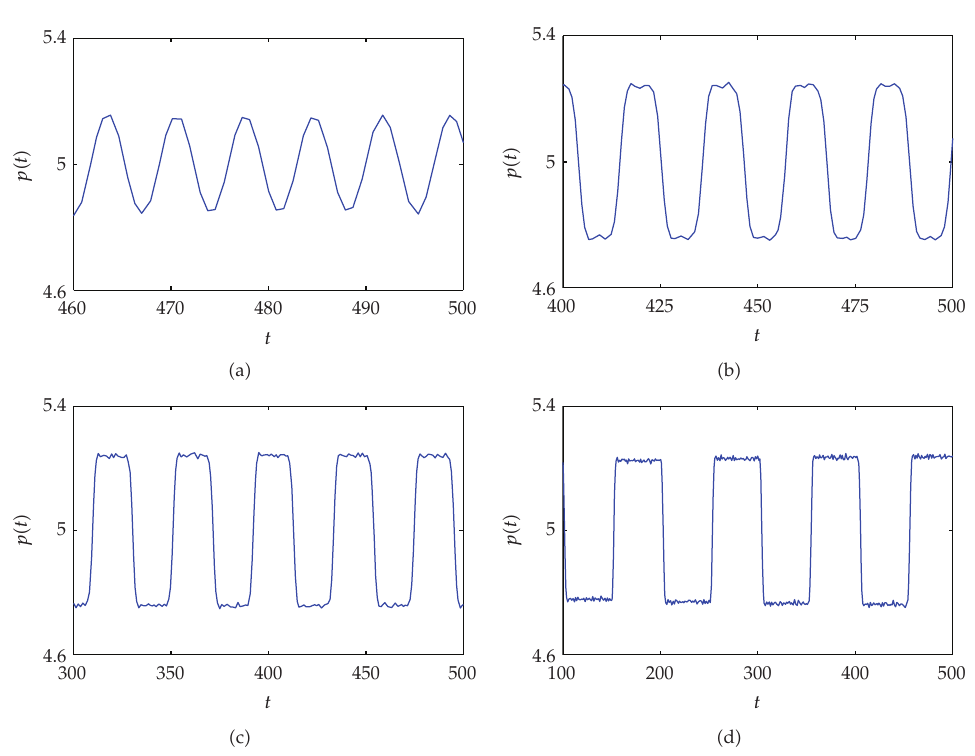
Figure 3: Stable periodic solution of (cid:4) P (cid:5) , where (cid:4) a (cid:5) with τ (cid:8) 2 . 9 > τ 0 (cid:8) 2 . 885, (cid:4) b (cid:5) with τ (cid:8) 10, (cid:4) c (cid:5) with τ (cid:8) 20, and (cid:4) d (cid:5) with τ (cid:8)